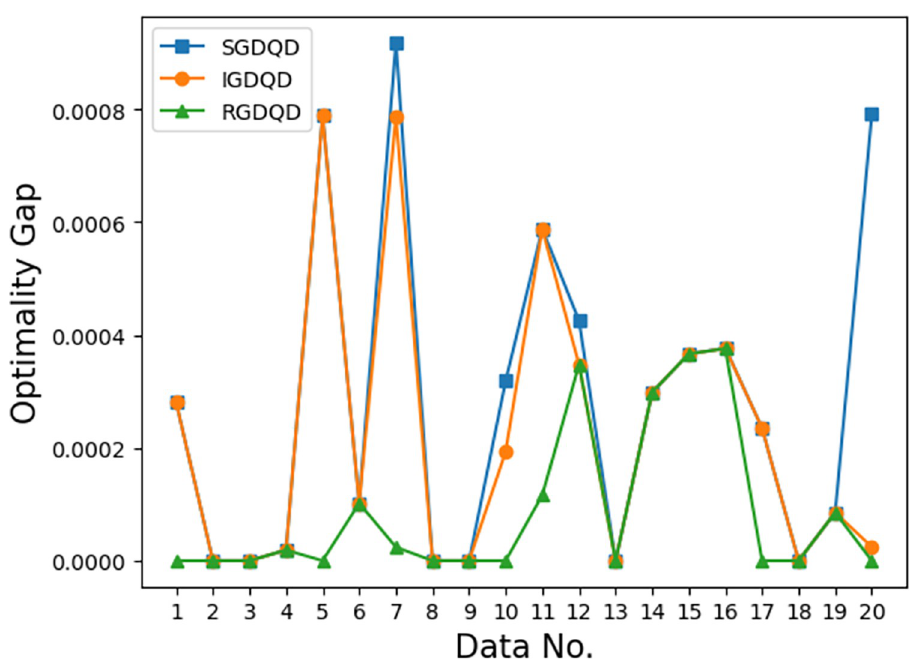
Fig 12. Comparison of optimality gaps for Q = 600000.